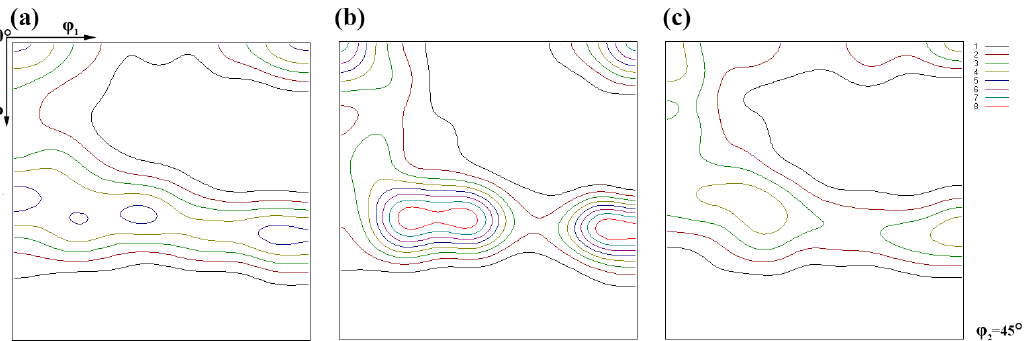
Figure 6. ODF image sectioned at ϕ 2 = 45 ◦ of specimen A ( a ), specimen B, ( b ) and specimen C ( c ).